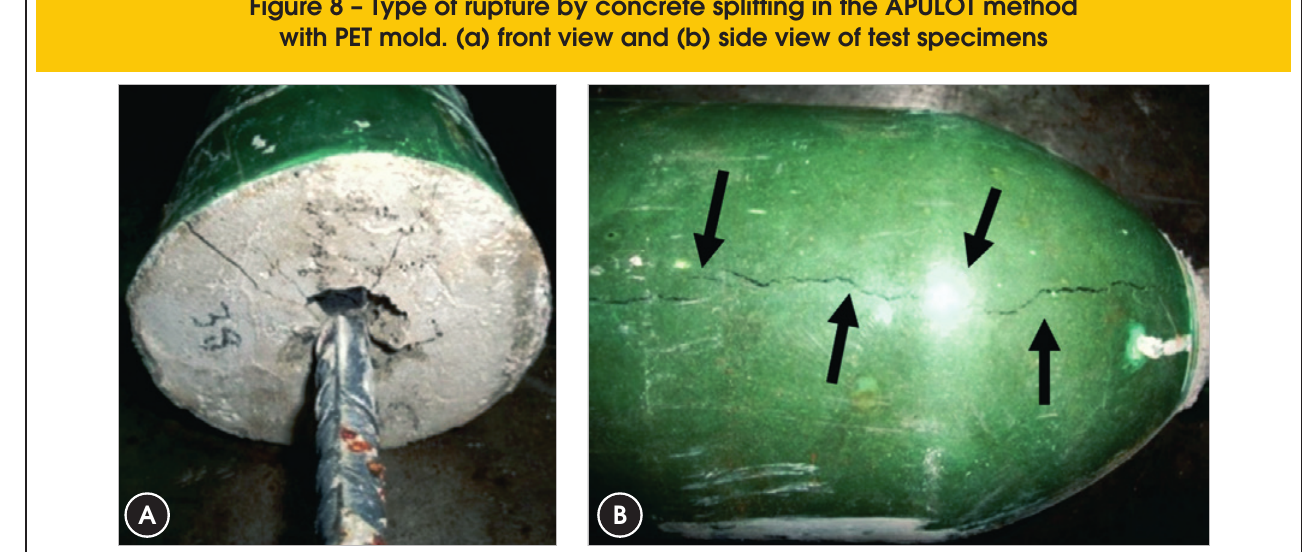
Figure 8 – Type of rupture by concrete splitting in the APULOT method with PET mold. (a) front view and (b) side view of test